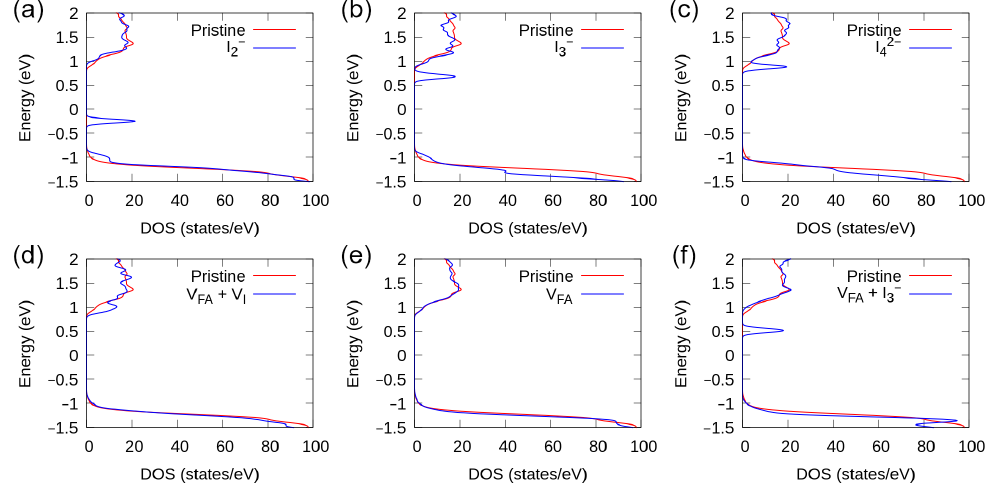
Figure 5. Density of states of each defect structure compared to the pristine perovskite. ( a ) iodine dimer (I − ), ( b ) iodine trimer (I − 2 mamidinium vacancy (V FA ), ( f ) iodine trimer in formamidinium vacancy (V FA + I −